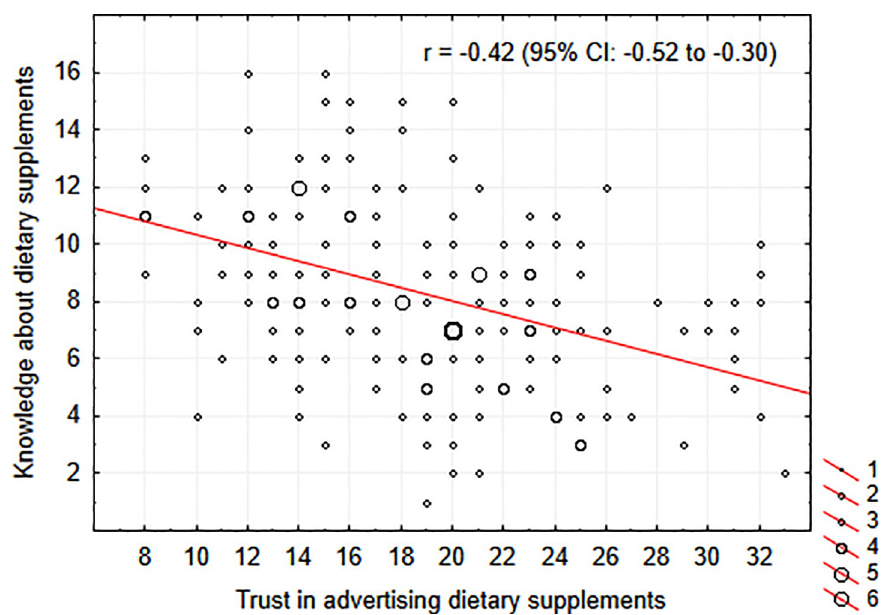
Fig 3. The association between knowledge about dietary supplements and trust in advertising them in non- medially educated people. Knowledge about dietary supplements was measured as a total score in the 17-item questionnaire, whereas trust in advertising dietary supplements with the eight-item questionnaire. The size of the circles represents the number of cases with the given coordinates.